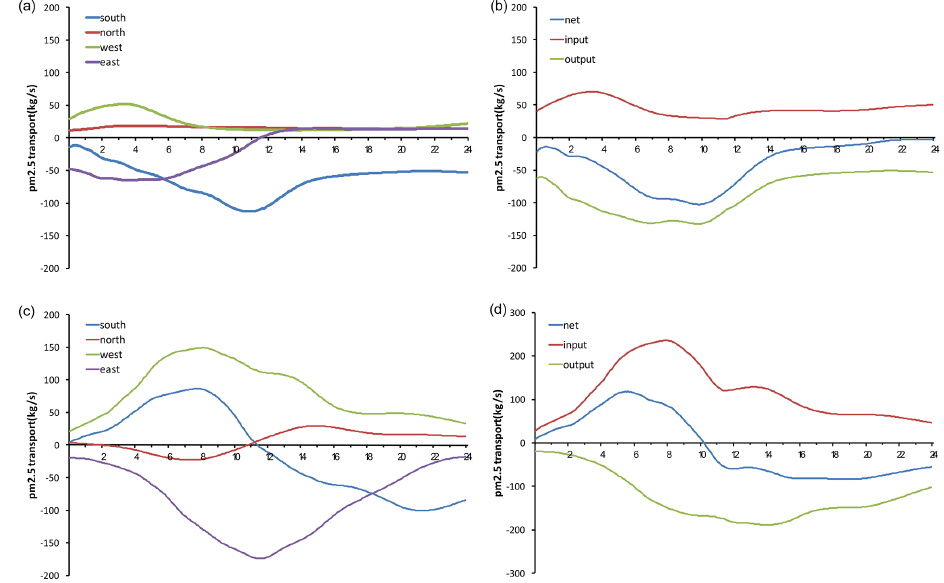
Figure 8. PM 2 . 5 transport rates (kgs − 1 ) from S, N, W and E of BJ on (a) 6 and (c) 7 December. Total input, output and net PM 2 . 5 transport rate (kgs − 1 ) from BJ’s environs on (b) 6 and (d) 7